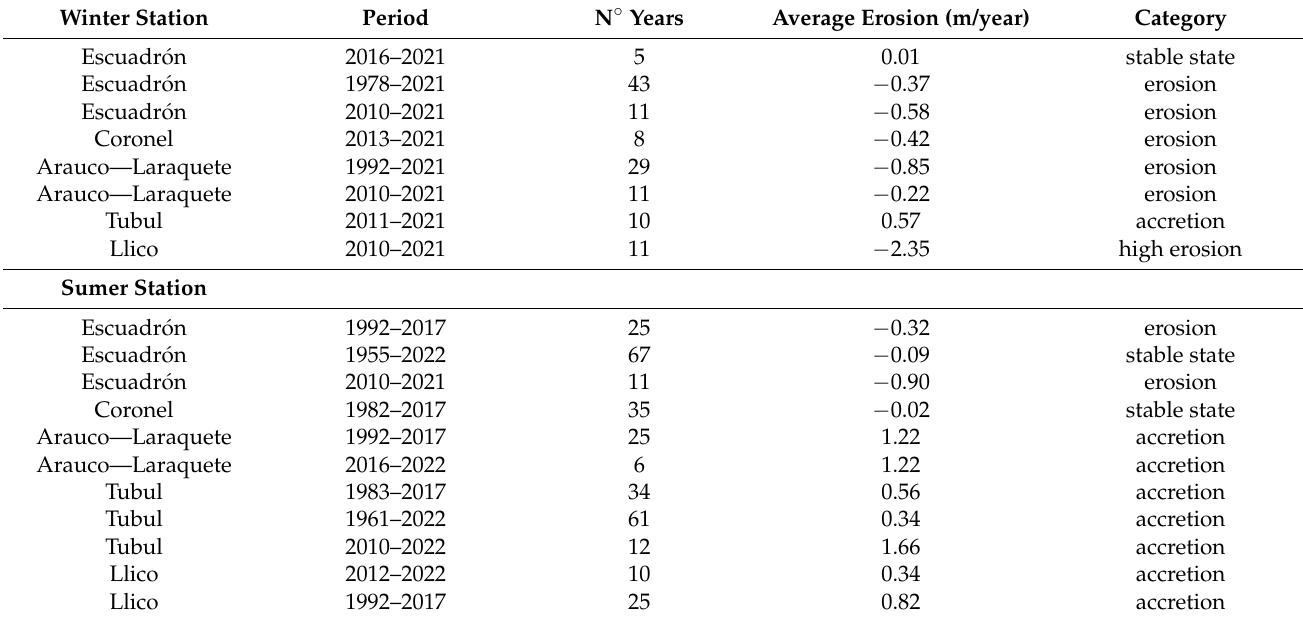
Table 2. Mean erosion rates for beaches in the Arauco Gulf across different time